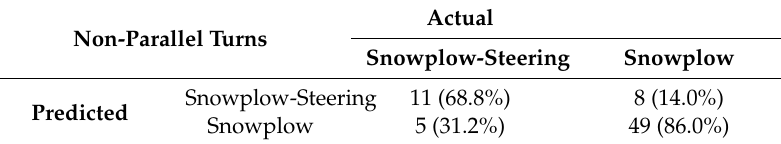
Table 9. Confusion matrix for non-parallel turns—Decision tree.